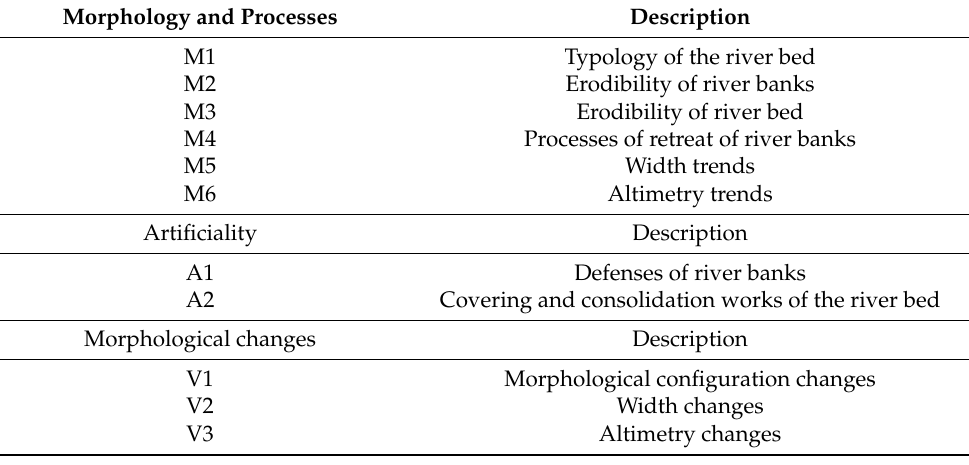
Table 4. Indicator classes for MDI determination.